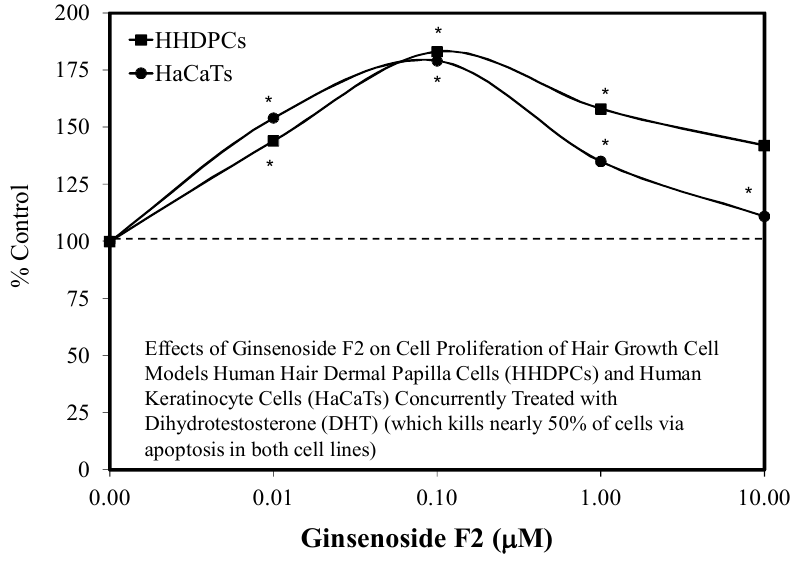
Figure 23. E ff ects of ginsenoside F2 on cell proliferation of hair growth cell models human hair dermal papilla cells (HHDPCs) and human keratinocyte cells (HaCaTs) concurrently treated with dihydrotestosterone (DHT) (which kills nearly 50% of cells via apoptosis in both cell lines) (Source: [94]). Each * represent statistical significance for a data